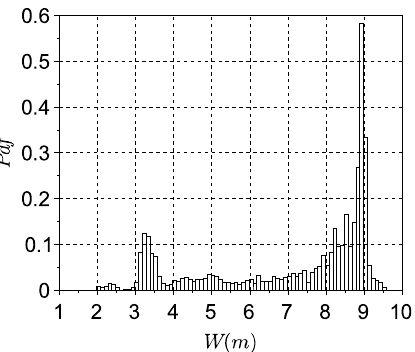
Figure 13. The distribution of measured width. The median class ranging from 4 to 7m is underrepresented because boulder clusters on each side of the stream make the transition between narrow flows and wide flows fast and